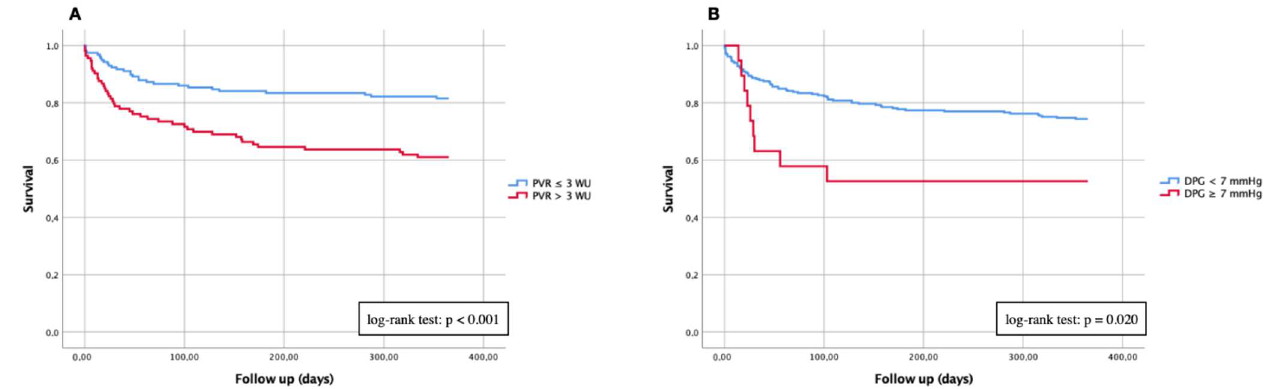
Figure 3. Kaplan–Meier curves of 1-year mortality in patients with severe AS. ( A ) Comparison of non-PH vs. PH; ( B ) comparison of non-PH and different PH subtypes; ( C ) univariate and multivariable Cox regression analyses of different PH subtypes. Prec-PH: pre-capillary pulmonary hypertension; Ipc-PH: isolated post-capillary pulmonary hypertension; Borderlinepc-PH: borderline post-capillary pulmonary hypertension; Cpc-PH: combined post- and pre-capillary pulmonary hypertension.